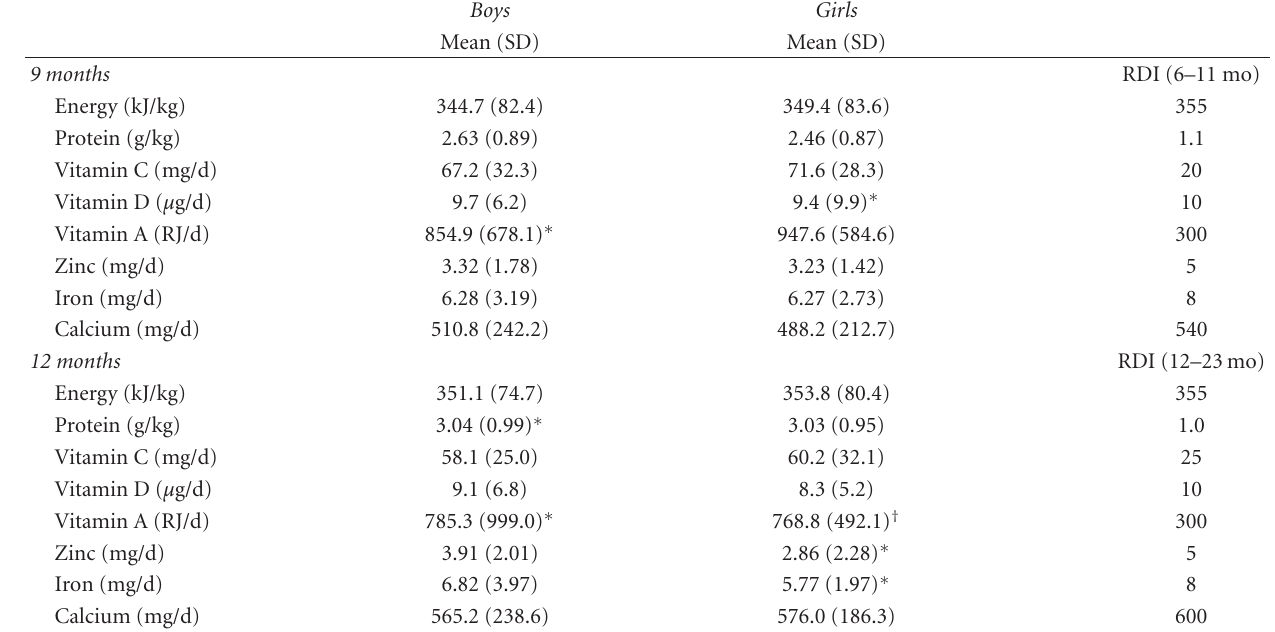
Table 3: Intake of selected nutrients among boys and girls at 9 and 12 months of age as an average intake over a 3-day period ( n = 122 at 9 months and n = 110 at 12